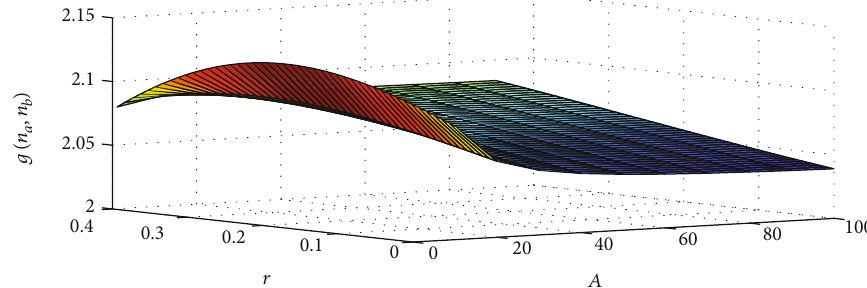
Figure 9: A plot of the photon number correlation of Equation (35) versus r and A of the two-mode cavity radiation for κ = 0 : 8 and η = 0 : 1